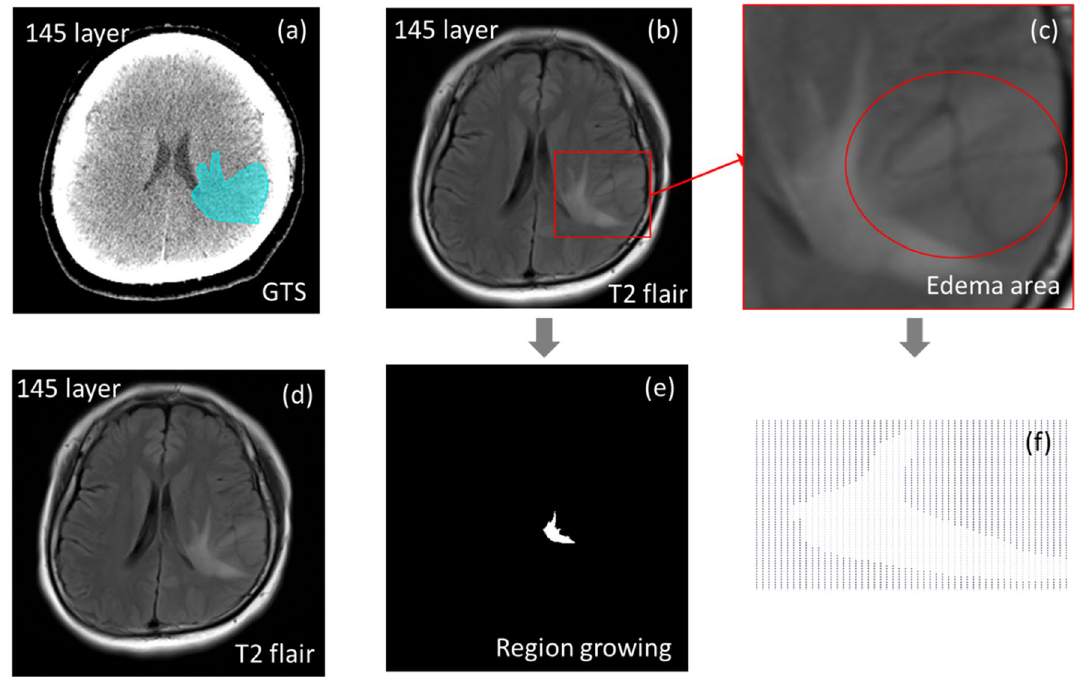
Figure 6. Cerebral edema Complications image comparisons between T2 flair image with region growing method and GTS image. Panel ( a ) shows the GTS image at 145 layer. Panel ( b ) shows the T2 flair image with region of interest. Panel ( c ) shows the edema area that boundary strength is not obvious. Panel ( d ) shows the T2 flair image. Panel ( e ) shows the segmentation result by using region growing method. Panel ( f ) shows the edema area which boundary strength is not obvious display by regional growth algorithm features. Abbreviations: GTS: ground truth segmentation. Image source statement: This image was created using CyberKnife M6 system. Software URL: https:// www. accur ay. com/ resou rces/ accur ays- cyber knife- m6-